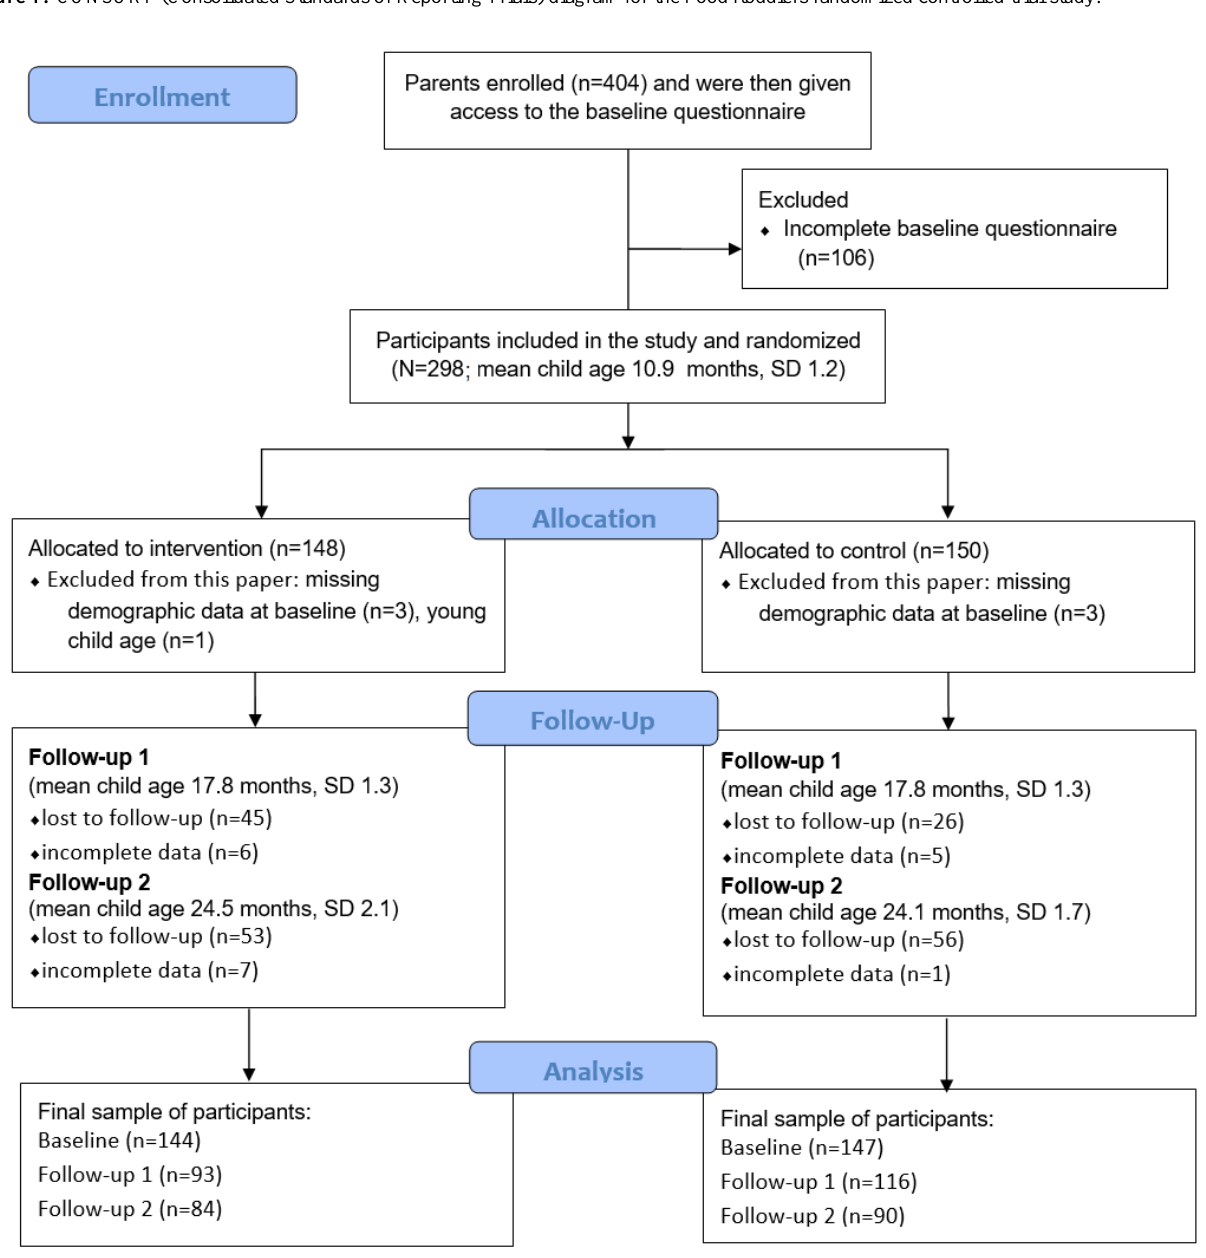
Figure 1. CONSORT (Consolidated Standards of Reporting Trials) diagram for the Food4toddlers randomized controlled trial